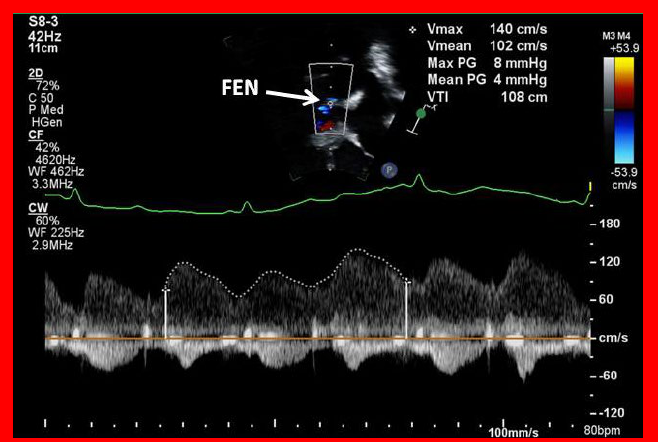
Figure 52. Selected video frame with Doppler sampling across the fenestration (Fen) demonstrating a mean gradient of 4 mmHg.